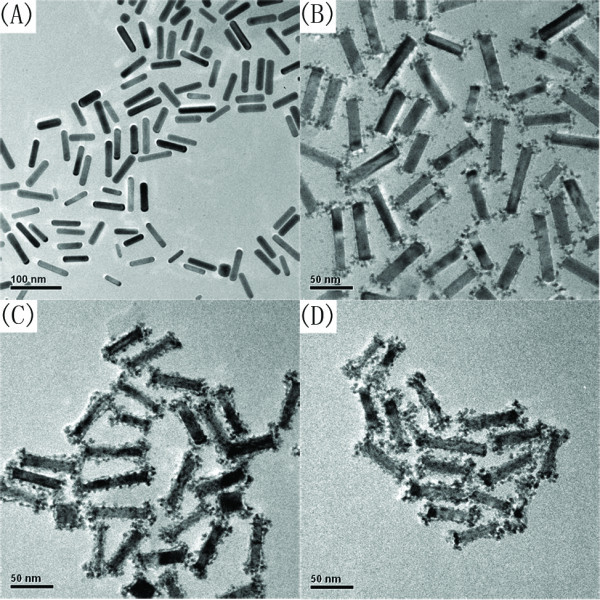
TEM images of gold nanorods (Au NRs) (A), Au@Pt0.34Ag0.66 NRs (B), Au@Pt0.57Ag0.43 NRs (C), Au@Pt0.64Ag0.36 NRs (D). Scale bar in (A) is 100 nm, in (B-D) is 50 nm.